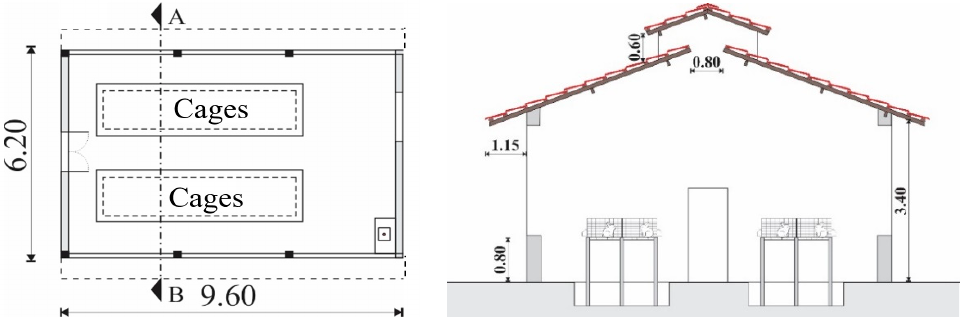
Figure 1. Rabbit house scheme. ( Left ) Floor plan of the rabbit house. ( Right ) Cut AB of the rabbit house section (B). Source: adapted from [1].